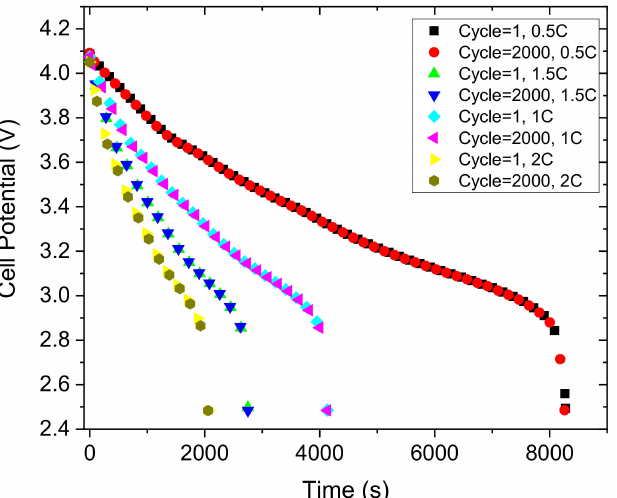
Figure 5. Simulated Comparisons of the discharge curves of 2000 cycles at four rates of discharge (0.5C, 1C, 1.5C, 2C) for NCA